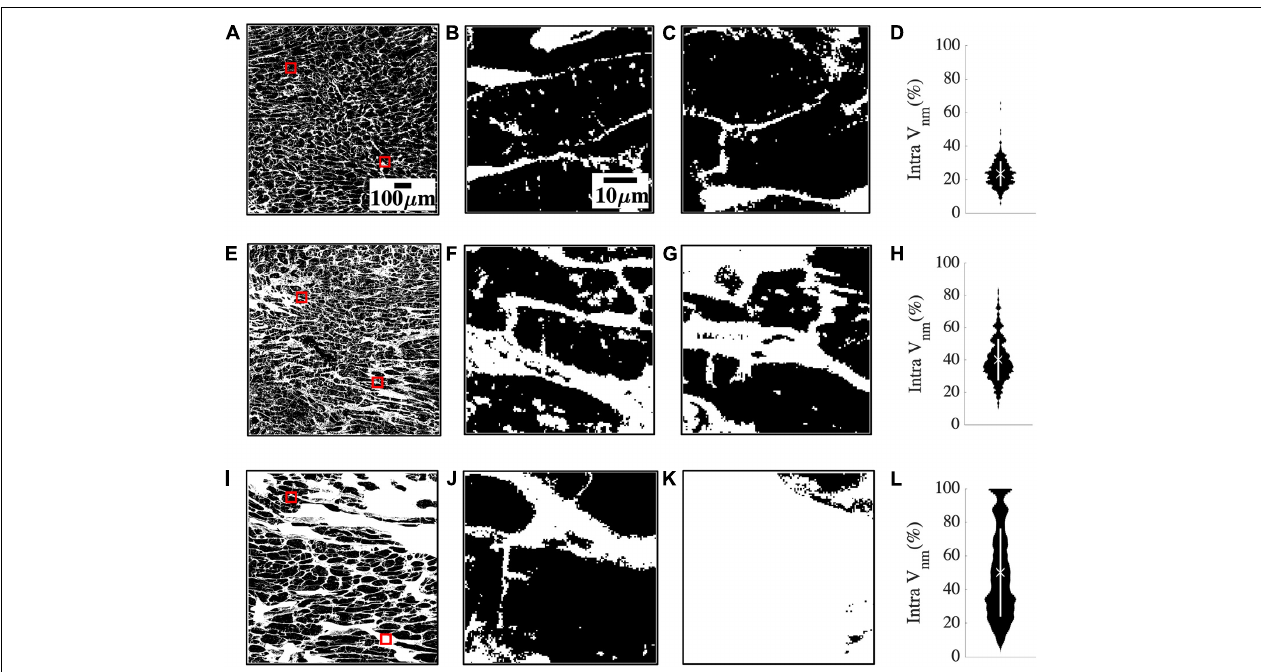
FIGURE 2 | Quantification of heterogeneity of V nm in a representative donor (A–D) , mean fibrosis HF (E–H) , and high fibrosis HF (I–L). (A) 1 mm 2 region of segmented non-myocyte space in white in a donor tissue section with two of the 400 sub-images of size 50 × 50 µ m 2 highlighted with red boxes. (B,C) Zoom-ins of regions within red boxes in panel (A) revealed normal myocyte membranes and capillaries. (D) The probability distribution of V nm in all the sub-images of panel (A) was narrowly spread. The mean marked with “X” aligned with the distribution peak, and SD marked with the white line segment was small. (E) Region of interest in HF tissue with fibrosis similar to the mean of all HF. (F,G) Magnified sub-images within red boxes in panel (E) indicated enlarged ES. (H) Though the probability distribution was spread wider than panel (D) , the mean V nm was close to the peak. (I) Region of interest in a high fibrosis HF tissue. (J,K) Magnified sub-images within red boxes in panel (I) were very different from each other. (J) Had enlarged interstitial ES while panel (K) was highly fibrotic and devoid of any myocytes. (L) The distribution was more uniformly spread out than panel (H) with the peaks away from the mean. Scale bar in panel (A) applies to panels (E,I) . Scale bar in panel (B) applies to panels (C,F,G,J,K) . TABLE 2 | Comparison of the binary clustering of HF as ischemic (IC) and nonischemic (NIC) cardiomyopathy by k -means algorithm applied to different features from image analysis. Clustering features Accuracy (%) Sensitivity (%) Specificity (%) Positive predictive value Negative predictive